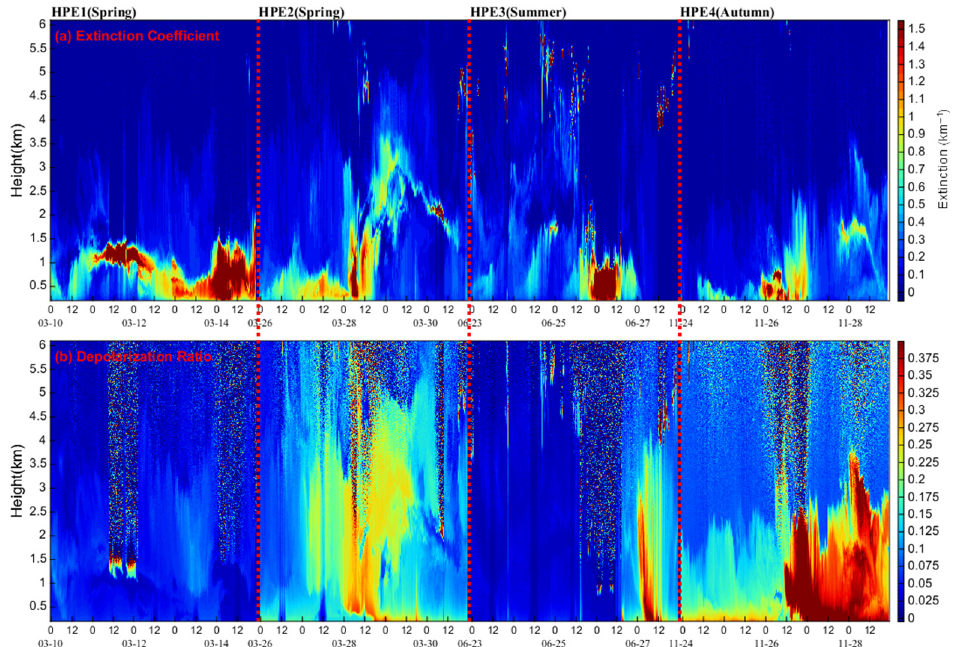
Figure 6. Spatiotemporal distribution of aerosol EC ( a ) and DR ( b ) retrievals from the Lidar for four heavy pollution episodes (HPE1, 2, 3, and 4) in Beijing in 2018.